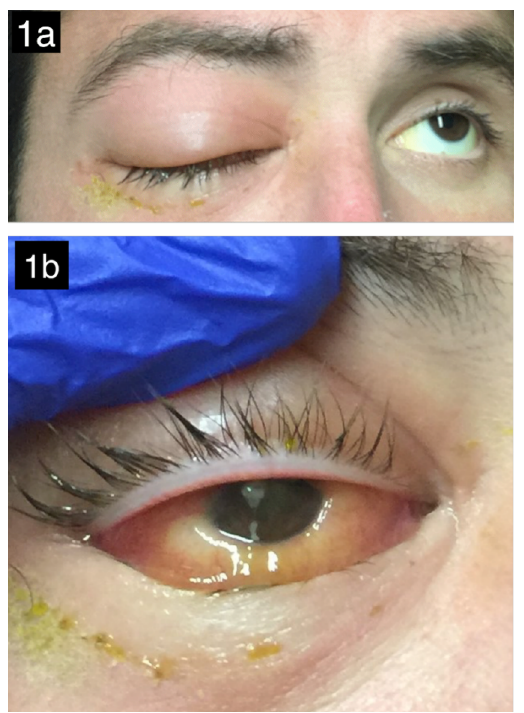
Figure 1: External photograph displaying moderate edema and erythema of the right upper and lower eyelids, as well as complete ptosis of the right upper eyelid (a). The left eye is unremarkable. External photograph of the patient’s right eye being manually opened (b). There is marked chemosis of the conjunctiva and mucous strands on the cornea. A pupillary hypopyon is partially visible.